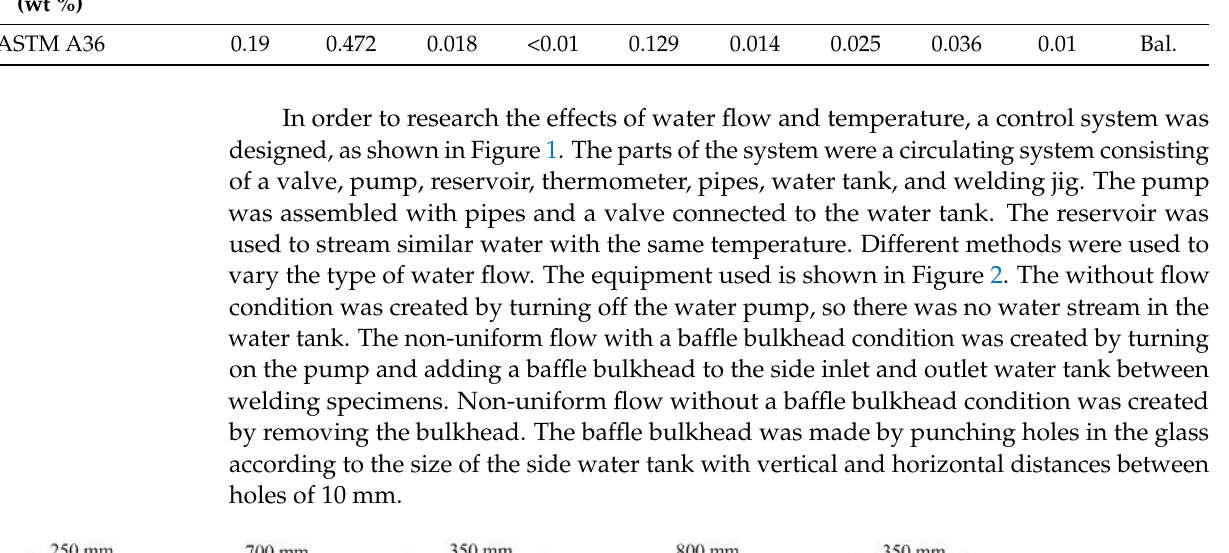
Table 1. Chemical composition ASTM A36.